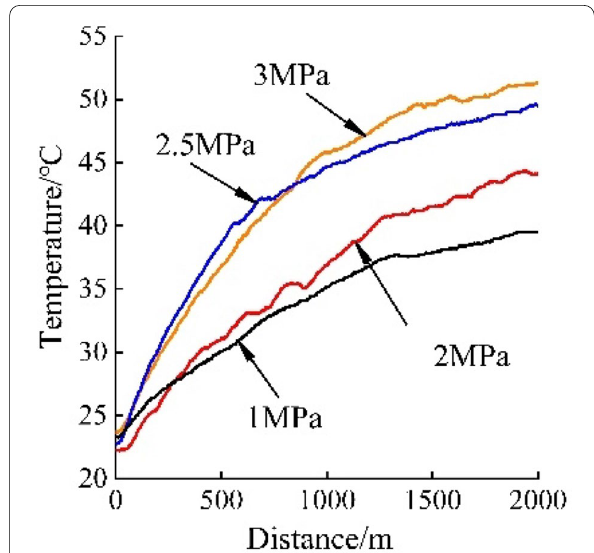
Figure 12 Effect of contact pressure on temperature at 1800 r/min